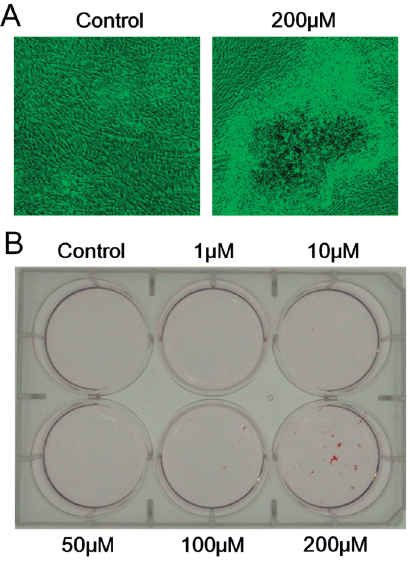
Figure 6. The effect of melatonin on mineralized matrix formation by DP-805 cells. DP-805 cells were seeded in 6-well culture plates at a cell density of 1 × 10 5 cells/well. The cells were treated with various concentrations (0, 1, 10, 50, 100 and 200 µM) of melatonin for 28 days. The phase-contrast images showed that DP-805 cells cultured in the presence of 200 µM melatonin formed mineralized matrix ( A ); and The extracellular matrix mineralization was evaluated by Alizarin Red S staining ( B